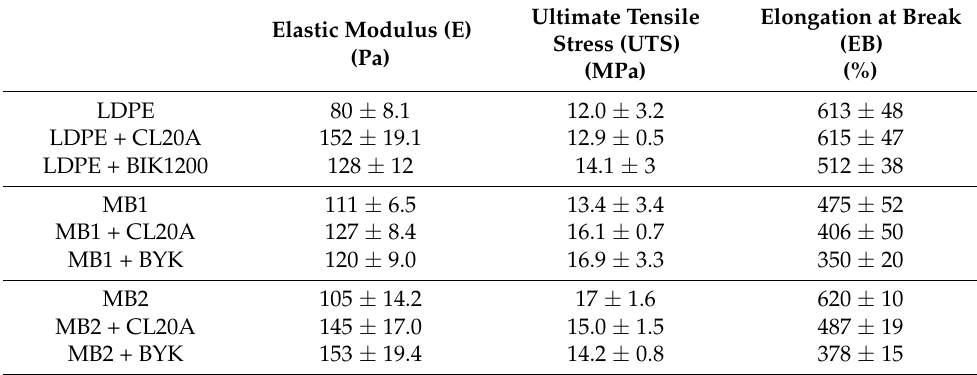
Table 2. Main mechanical properties of all investigated materials.